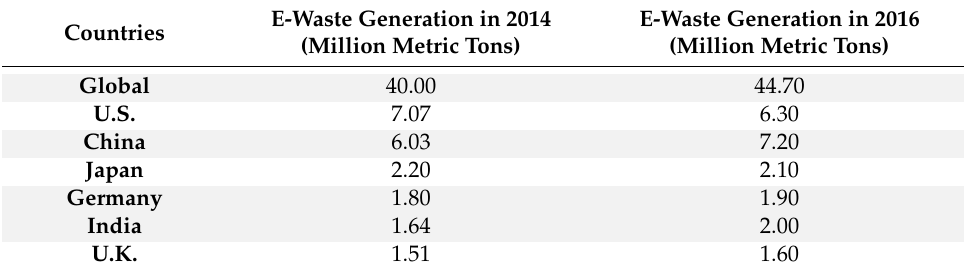
Table 1. Global generation of